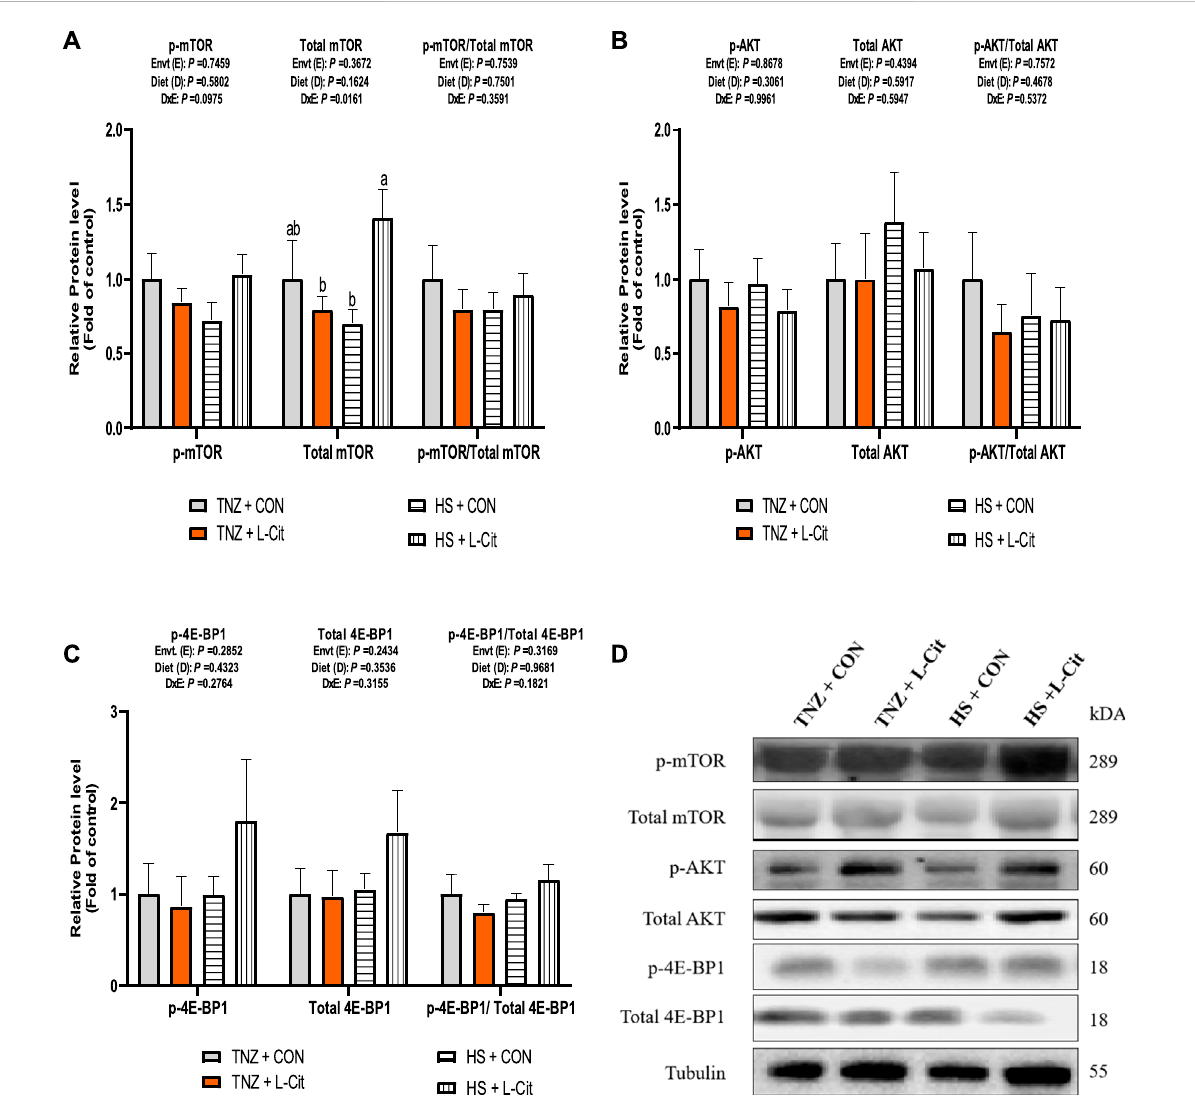
FIGURE 4 Effect of heat stress and l-citrulline supplementation on mTOR signaling pathway (A) phosphorylated, total and ratio of phosphorylated to total mTOR (B) phosphorylated, total and ratio of phosphorylated to total AKT (C) phosphorylated, total and ratio of phosphorylated to total 4E-BP1 (D) Western blot images of tested proteins. Data were presented as mean ± SEM. Means with different alphabetical superscripts indicate signi fi cant differences in environment × diet interaction at p <